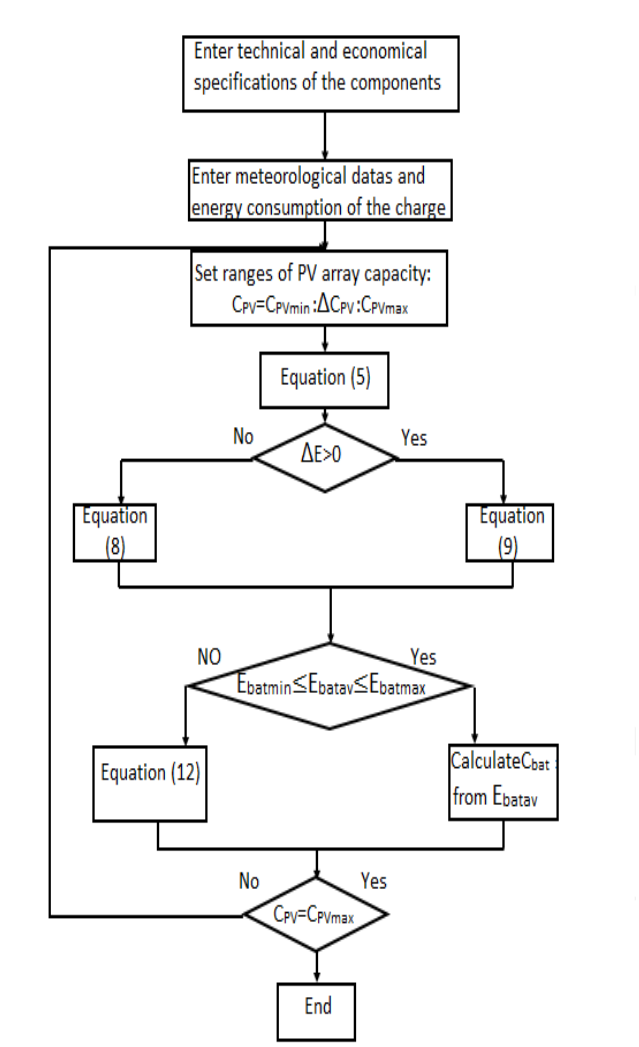
Figure 5. Calculation of the system storage capacity